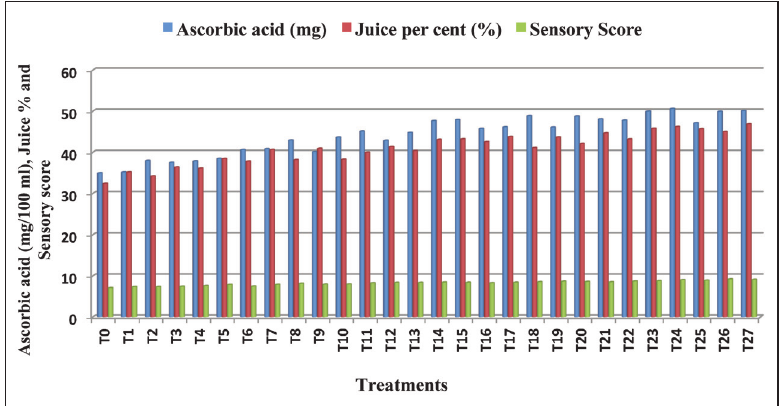
Figure 1 Interaction effect of pre harvest spray of calcium nitrate, boric acid and zinc sulphate on ascorbic acid (mg / 100 ml juice ), Juice per cent and Sensory Score of Nagpur mandarin ( Citrus reticulata